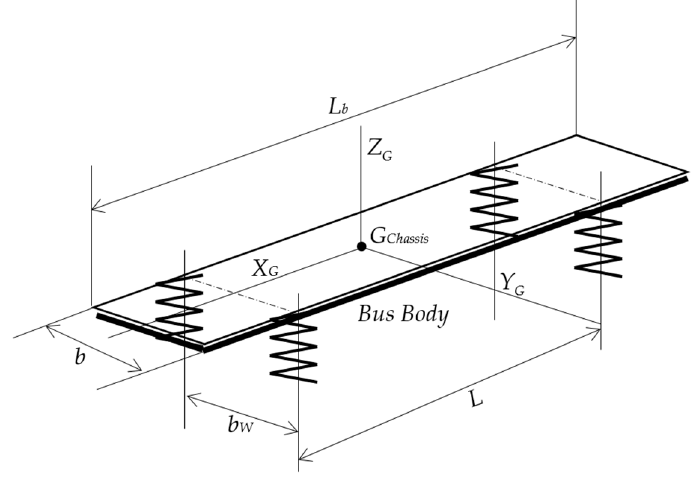
Table 1. Characteristics of the studied model.